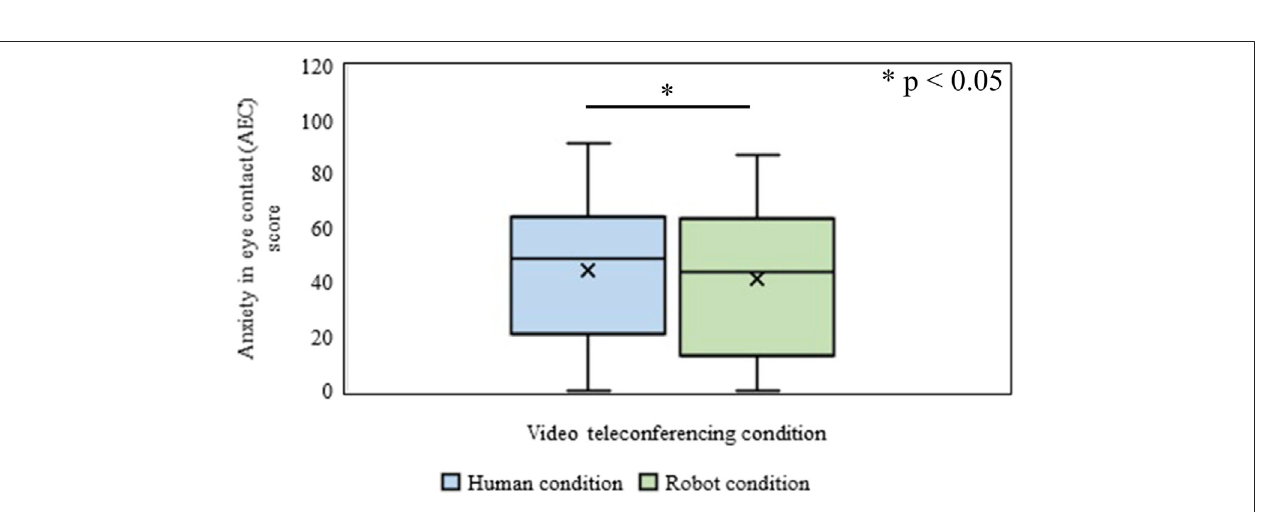
Frontiers in Robotics and AI |